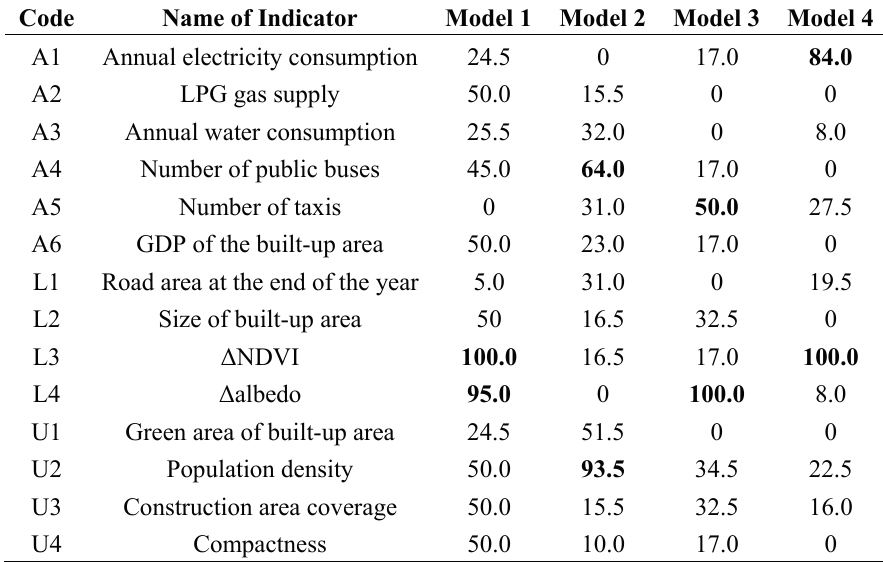
Table 5. Importance of input variables for each model. Note: Detailed information on Models 1–4 is listed in Table 3. The number indicates the relative importance of each factor to SUHII, with 100 being the largest possible score and 0 the smallest score. The bold font indicates the two most important